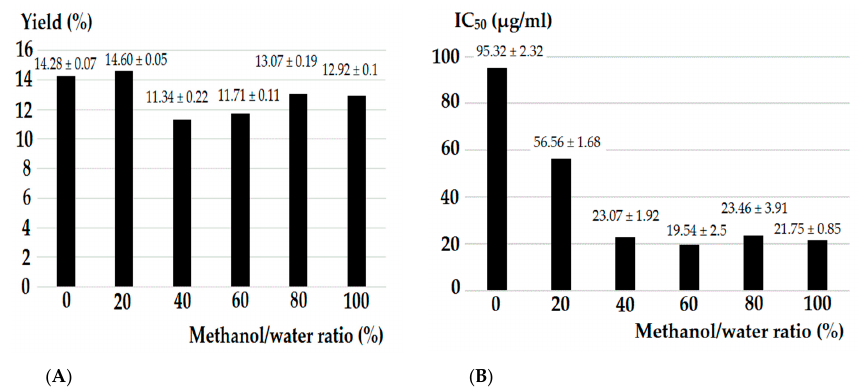
Figure 2. Extraction yield (%) ( A ) and α -glucosidase inhibitory activity (IC 50 ; µg/mL) ( B ) of T. scandens leaves hydromethanolic extracts. Values expressed as the mean ± standard deviation of six replicates. IC 50 value of the positive control (Quercetin) was 3.29 ± 0.48 µg/mL.